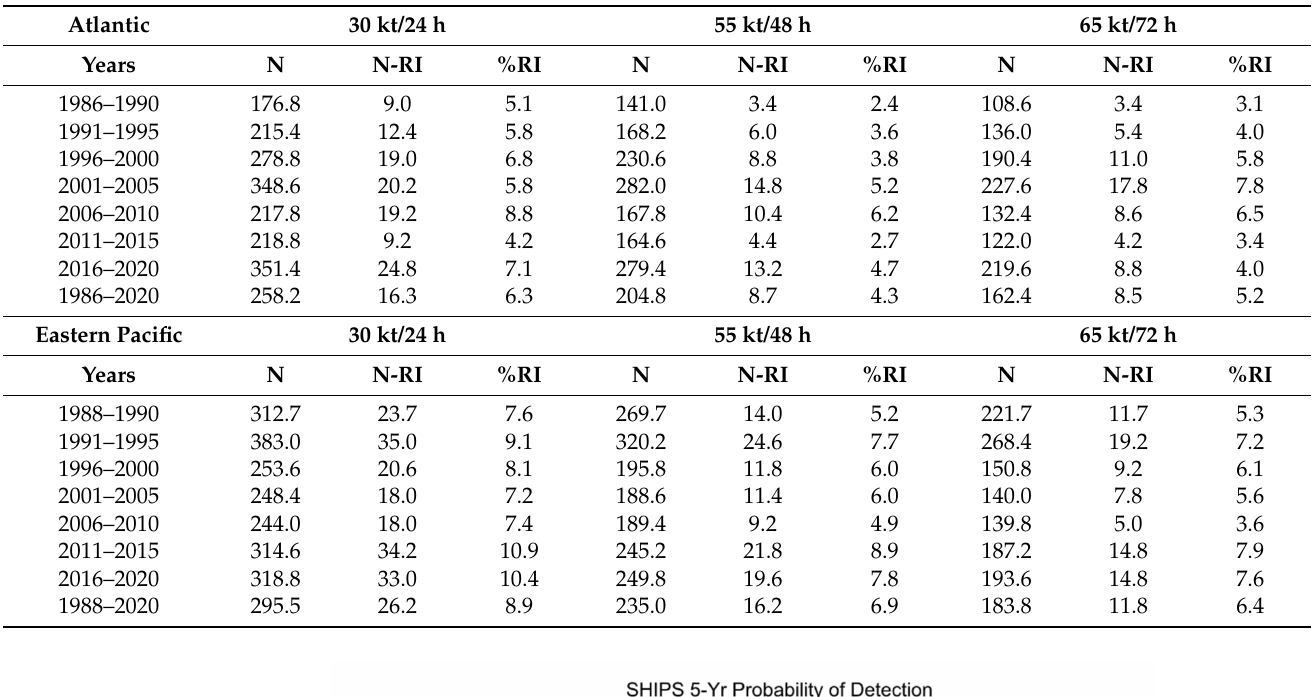
Table 5. Sample sizes of the NHC official forecasts, which is the maximum for the deterministic model verification. N is the yearly average number of forecasts, N-RI is the yearly average number of RI cases, and %RI is the percent of forecasts where RI was observed.